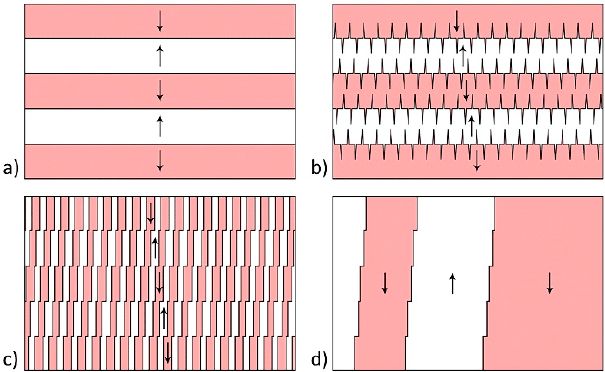
Figure 5. Schematic images of irregularly shaped domains formation: ( a ) Initial domain structure, ( b ) switching in both directions, ( c ) pass-through switching in stripe domains, and ( d ) long domains with neutral domain walls and charged steps. The arrows indicate the spontaneous polarization directions.